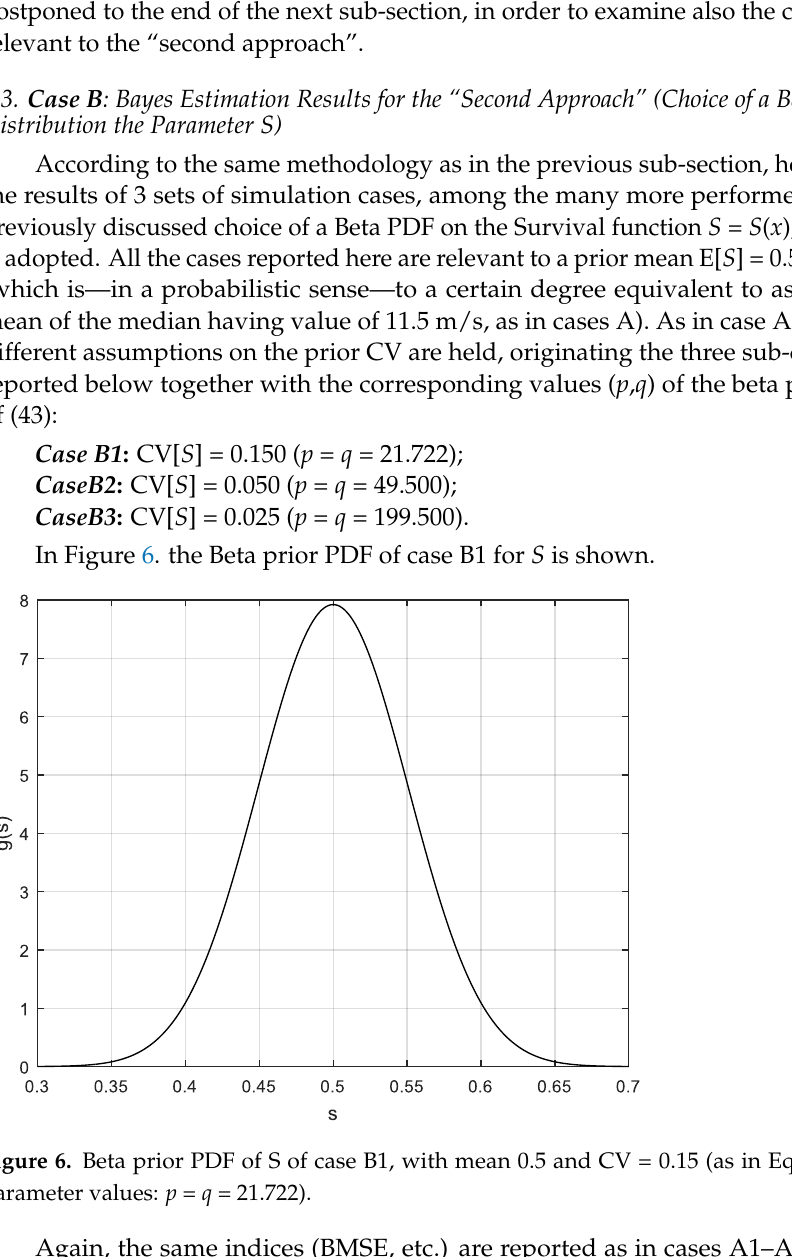
Table 8. Estimation efficiency: numerical results for case B1. n (Sample Size)